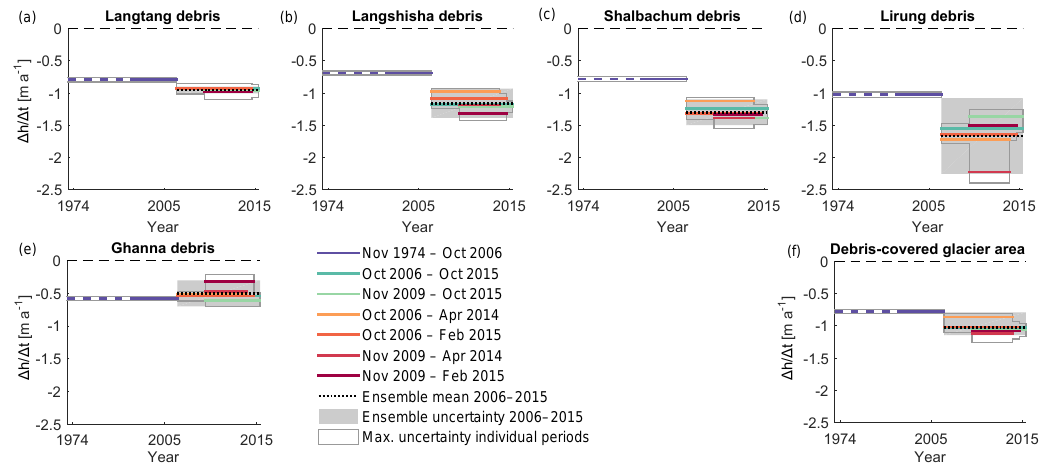
Figure 8. Mean elevation change rates ( (cid:49)h/(cid:49)t ) per period and debris-covered glacier area. For better readability, only the maximum width of error bounds corresponding to individual periods 2006–2015 is shown. Note that the 1974–2006 timescale is not linear (dashed dark blue